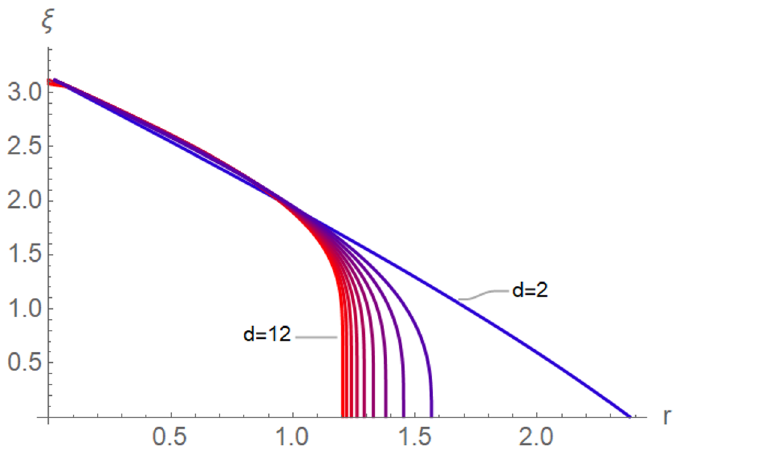
Figure 1 . Numerical solution for equation (3.19) with pion-mass type